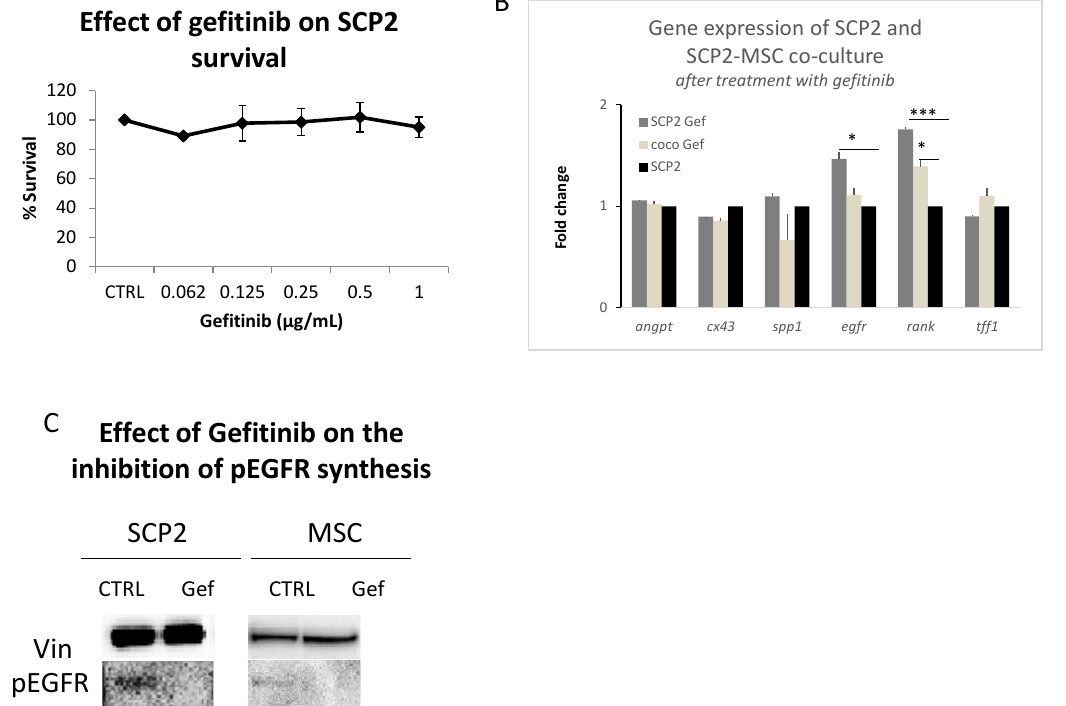
Figure 4. Gef inhibits the EGFR pathway and modulates cancer cell gene expression analyses. ( A ) Survival rate of SCP2 treated with Gef. Data were normalized to untreated sample (CTRL); ( B ) Expression of angpt1 , cx43 , spp1 , egfr , rank and tff1 in SCP2 cells (SCP2 Gef) or in SCP2-MSC COCO (TRW Gef) treated with Gef 1 µ g/mL. Fold change compared to SCP2 culture at baseline. * p < 0.05. *** p < 0.01; ( C ) Synthesis of phosphorylated-EGFR (pEGFR) in SCP2 and MSC in absence (CTRL) and treated with Gef. In each condition we added EGFR with an incubation step of 10 min (50 ng/mL).